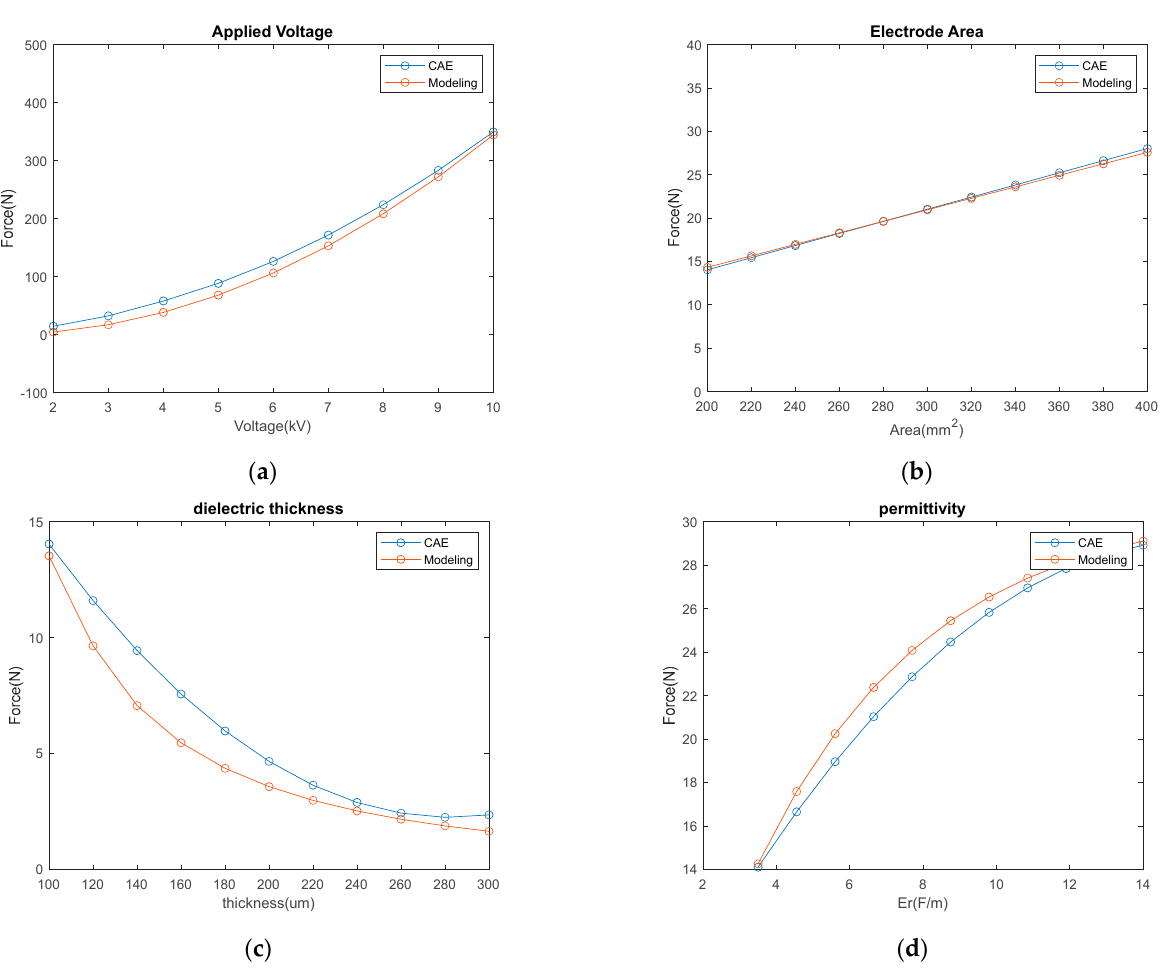
Figure 10. Modeling and analysis data comparison verification: ( a ) applied voltage; ( b ) electrode area; ( c ) dielectric thickness; ( d ) dielectric permittivity.